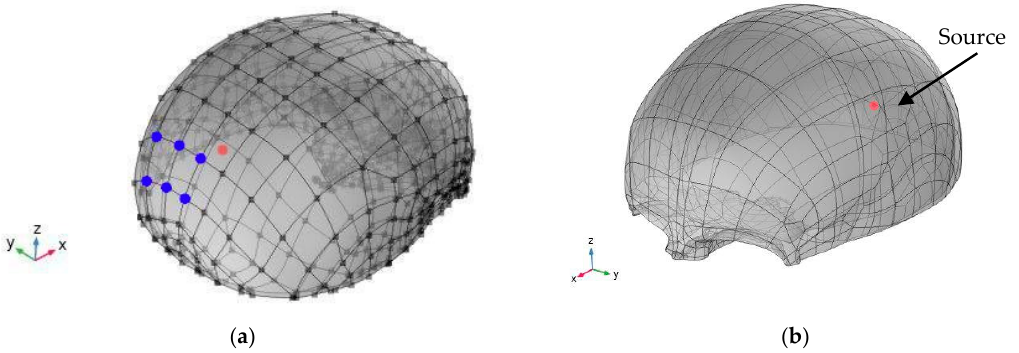
Figure 1 . ( a ) Position of the sensors in the skull where the acceleration produced by the propagation of the pressure pulse will be evaluated; ( b ) Simulated volume and pressure source.